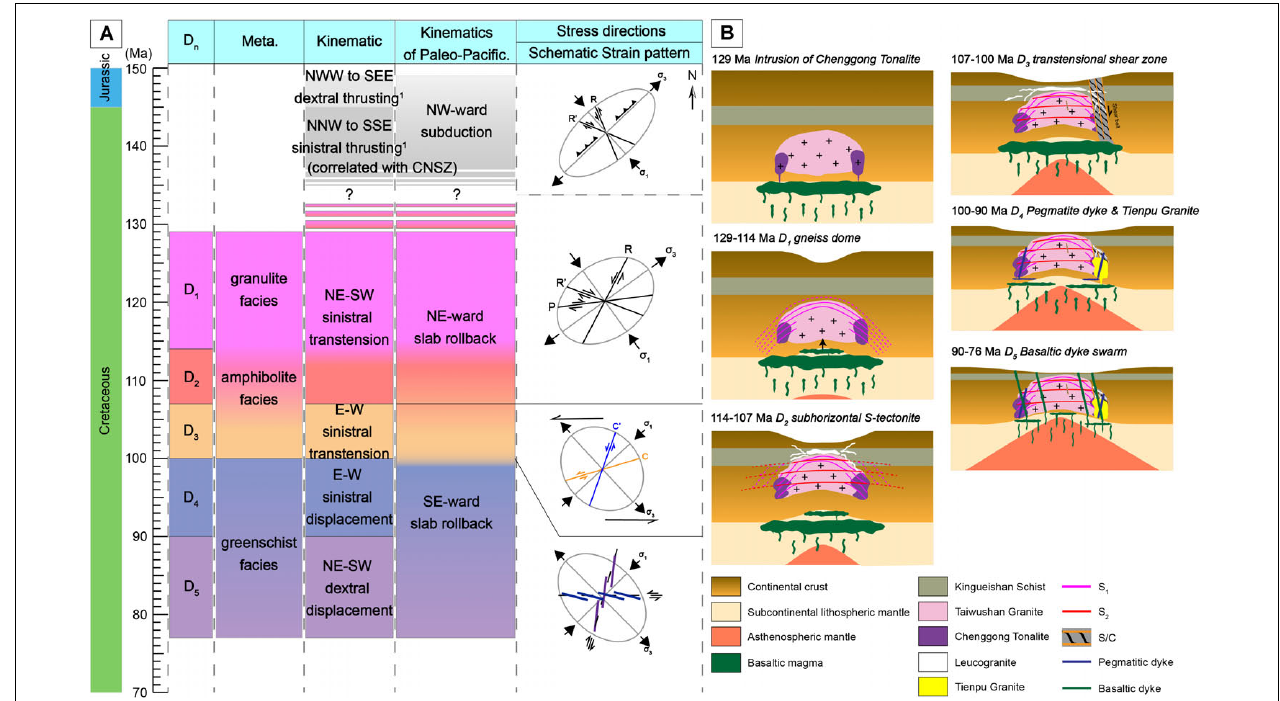
FIGURE 13 | A compiled diagram showing the structural and tectonic evolution of the Kinmen Island. (A) Composite diagram showing the reconstructed structural evolution and the associated plate kinematics and the schematic strain pattern. The structural evolution of Kinmen is correlated to the regional-scale Changle-Nanao Shear Zone (superscript 1; Shi, 2011). Besides, the normal fault systems of the extensional basins within the Cathaysia Block (Li J. et al., 2014) is compiled to constrain the stress field during D 1 –D 2 . (B) Schematic diagram of the tectonic evolution of the Kinmen Island between 129 and 76 Ma. Both horizontal and vertical dimensions are not to